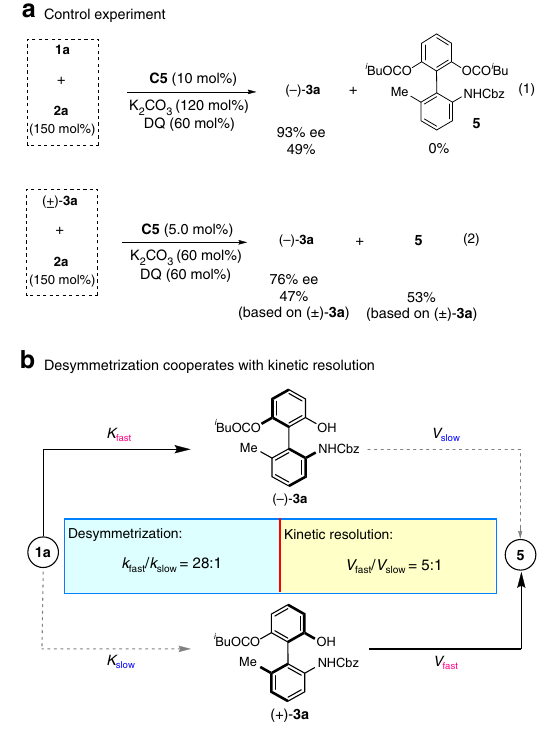
Fig. 4 Postulated mechanistic pathways. a The control experiments (Eqs. (1) and (2)) show that the desymmetrization process is the main contributor to the observed ee of the product and the second acylation is a effective KR process that could improve the ee of ( − )- 3a . b The postulated mechanistic pathway to generate product ( − )- 3a